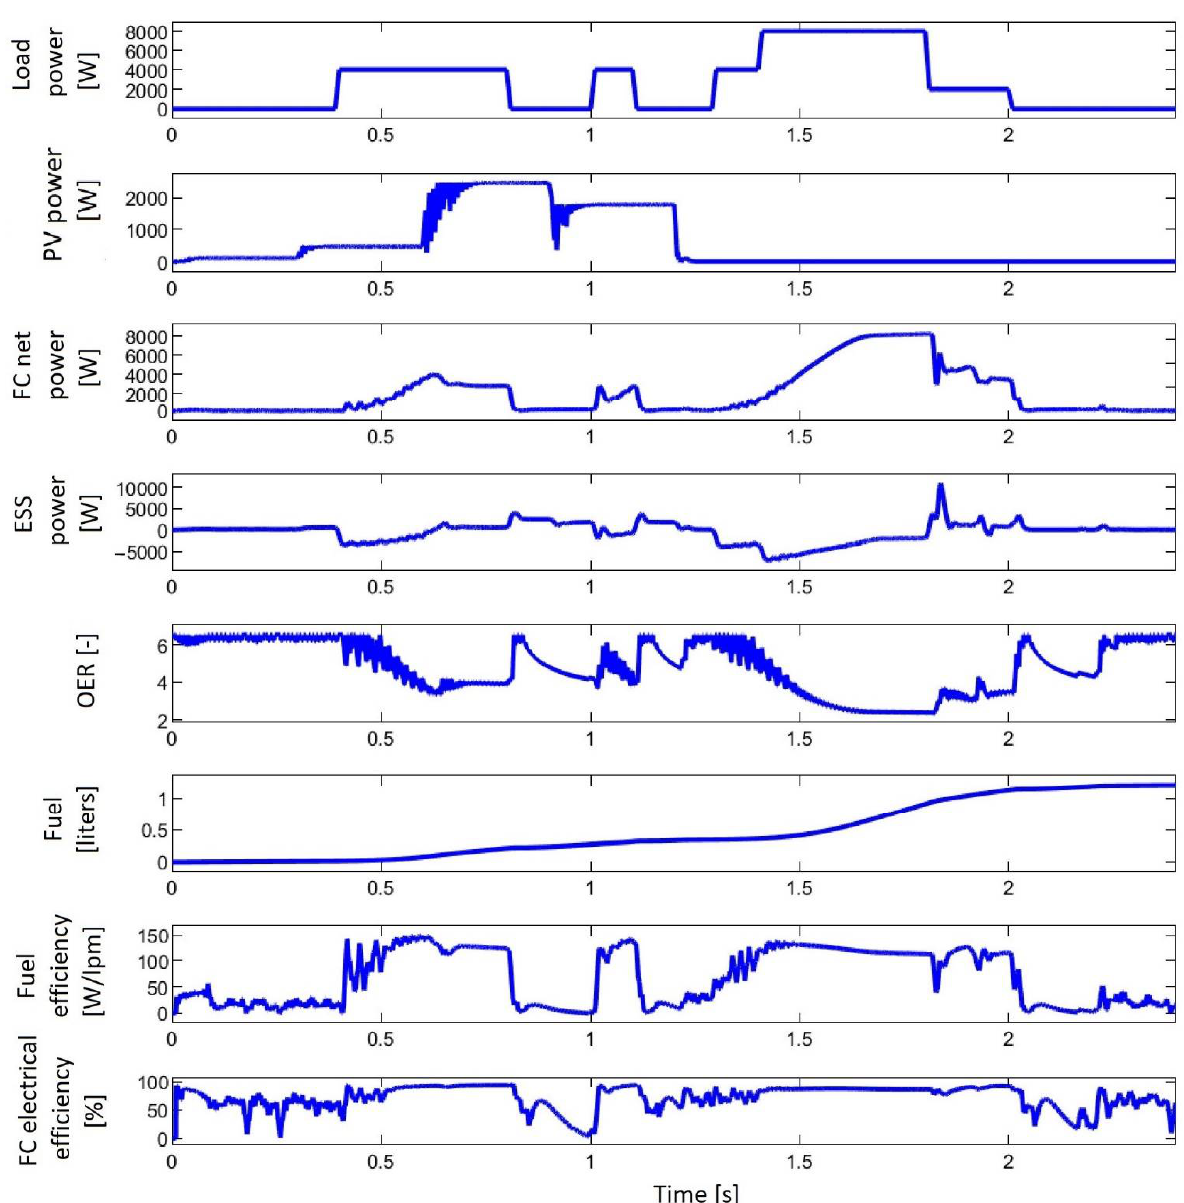
Figure 14. The behavior of the PV/FC/ESS system using strategy S2 in the scenario SC5.